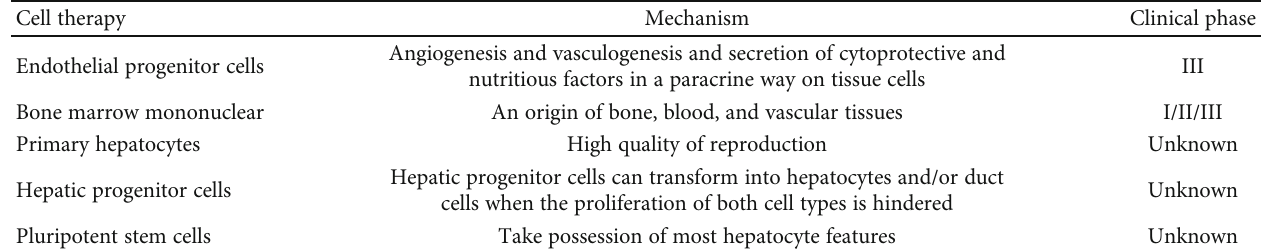
Table 2: Potential cell therapy for hepatic fi